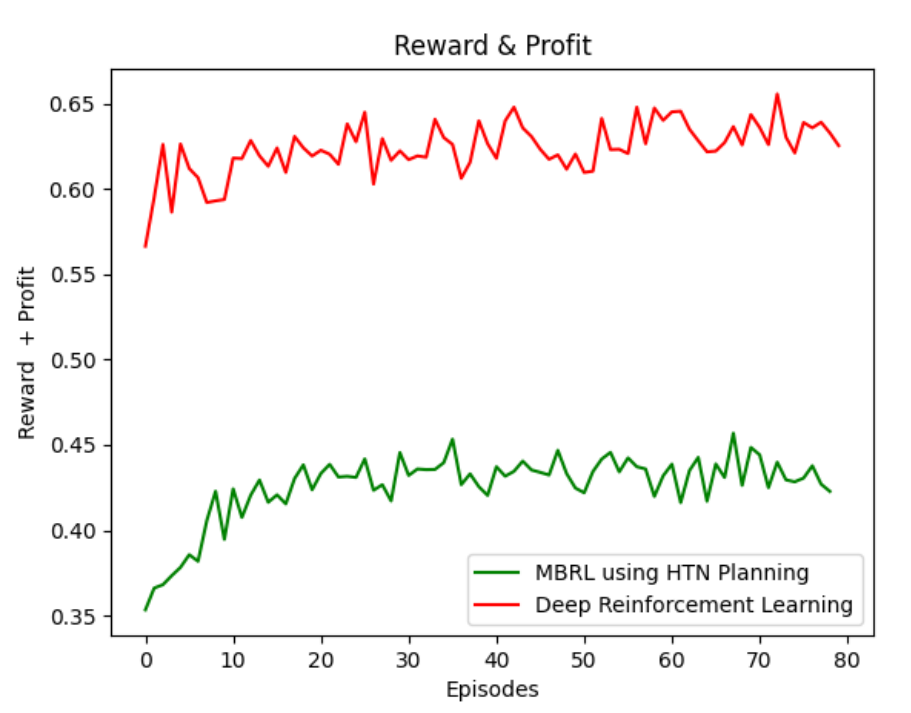
Figure 7. DeepRL vs. Model-based